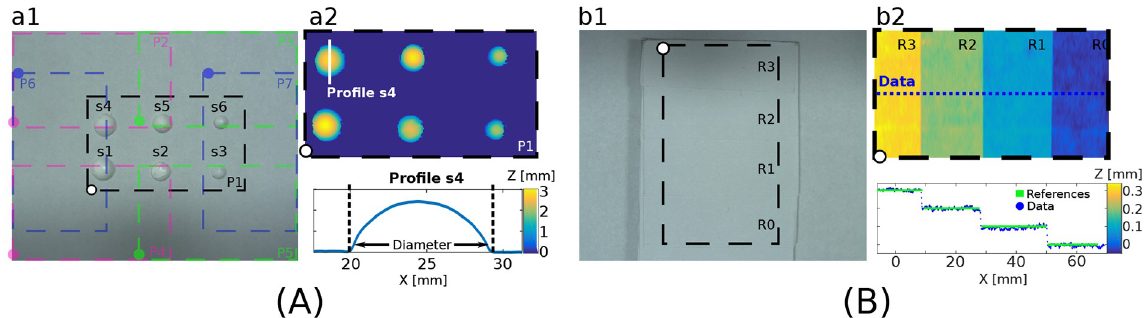
Fig 3. Validation experiments: (A) measuring spherical caps of known diameters and (B) steps with known